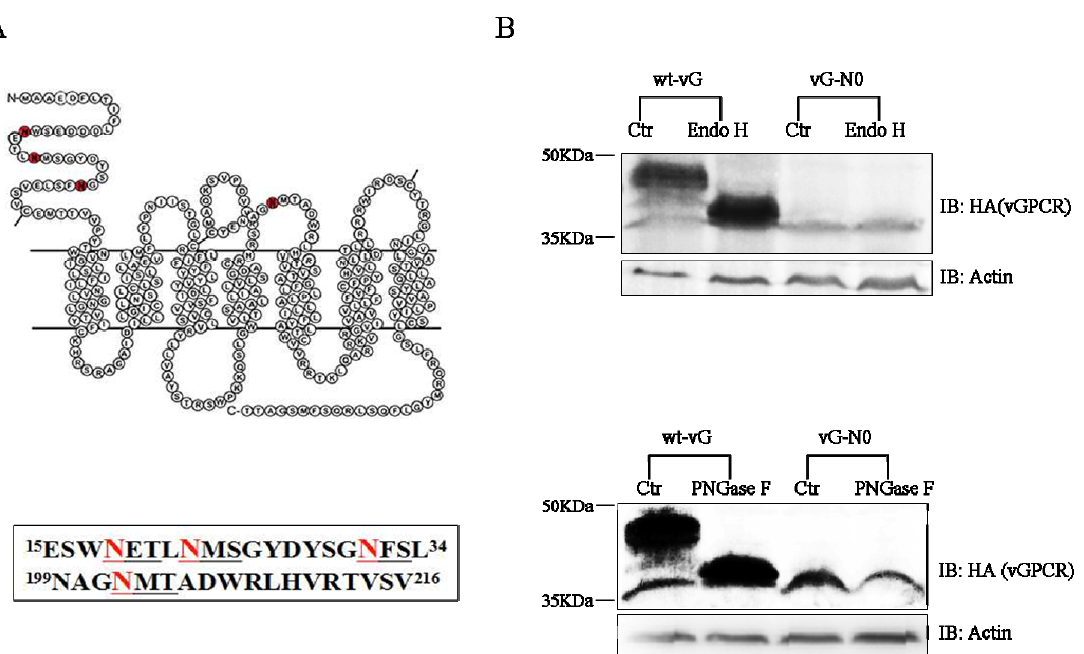
Figure 1. Kaposi’s sarcoma-associated herpesvirus ( KSHV) G protein-coupled receptor (vGPCR) undergoes post-translational modification of N-linked glycosylation within its extracellular sequences. ( A ) There are four potential N-linked glycosylation sites in vGPCR. Upper panel: sketch-map of vGPCR and four Asn residues in red (18, 22, 31 and 202); Lower panel: N-X-S/T consensus sequence (underlined) for N-linked glycosylation in vGPCR. ( B ) Glycosidase digestion of vGPCR and vGPCR-N0. HEK293T cells were transfected with FRT-TO-HA-vGPCR or un-glycosylated vGPCR mutant N0, cells were harvested at 48 h posttransfection and lysed, whole cell lysates were digested with Endo H (upper panel) or PGNas F separately. wt-vG: FRT-TO-HA-vGPCR; vG-N0: FRT-TO-HA- vGPCR-N0; Endo H:Endoglycosidase H; PNGase F:Peptide - N -Glycosidase F;